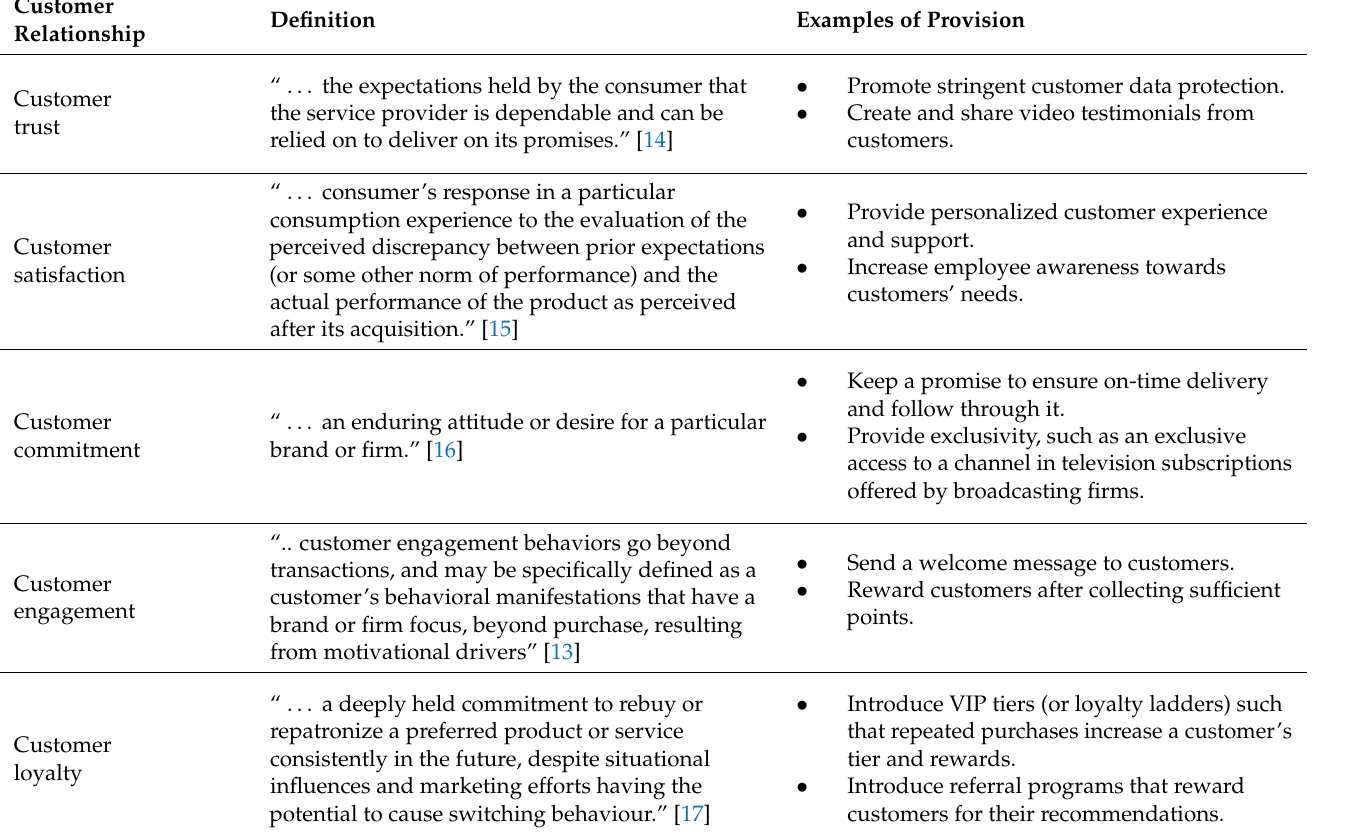
Table 1. Customer relationship definitions and examples of